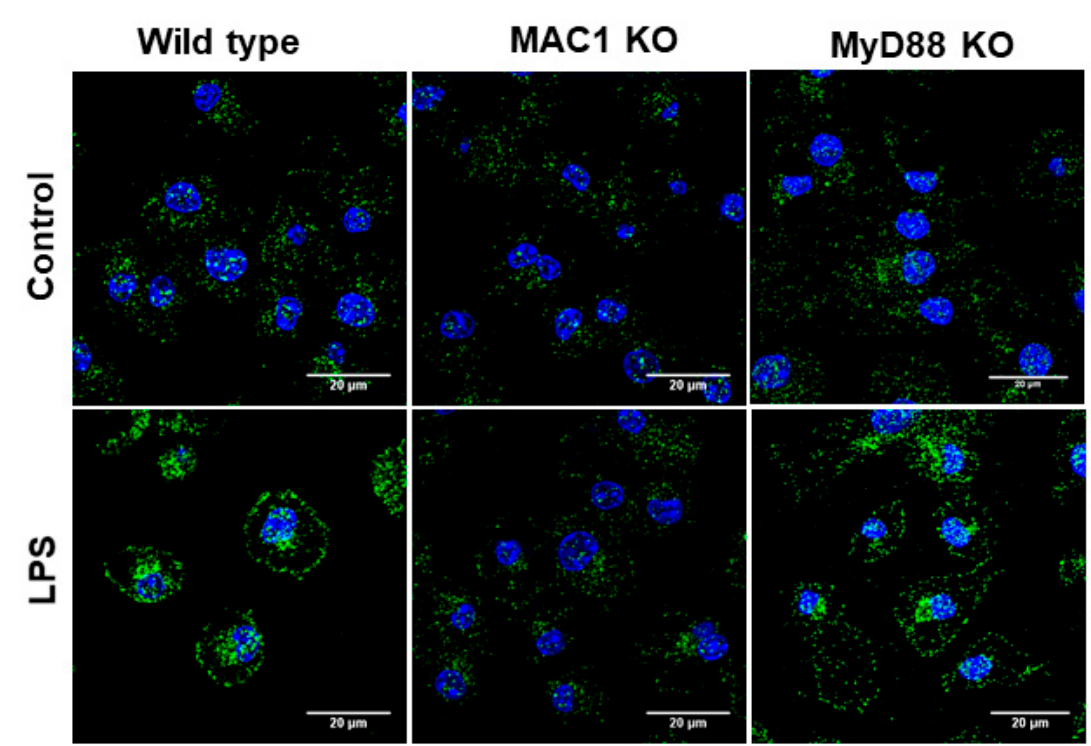
Figure 5. LPS-elicited p47 phox translocation was reduced in MAC1 KO microglia. Microglia from wild type, MAC1 KO, and MyD88 KO were fixed and stained with p47 phox 60 min after being stimulated with LPS (100 ng/mL).